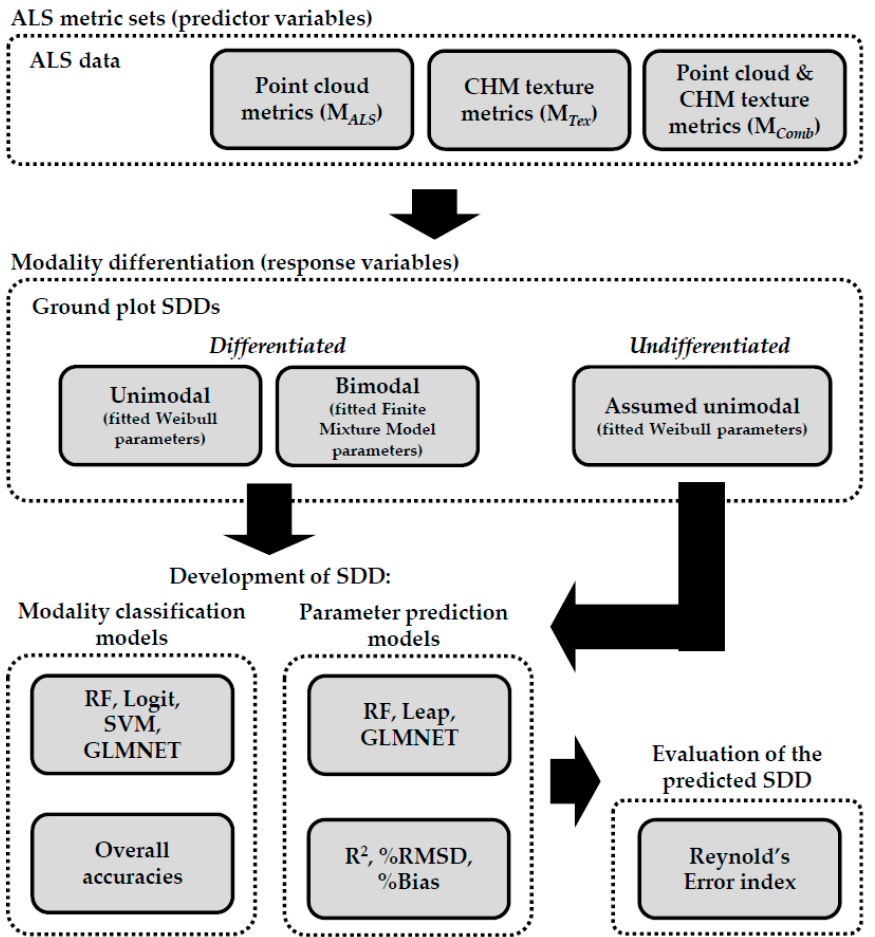
Figure 3. Overview of the methodological approach for assessing the contribution of CHM texture metrics and modality differentiation in predicting stem diameter distribution (SDD) parameters. CHM = Canopy Height Model; RF = Random Forest; Logit = generalized linear model with stepwise feature selection; SVM = Support Vector Machine; GLMNET = Generalized linear model through penalized maximum likelihood; Leap = Best subset regression with branch-and-bound algorithm; R 2 = Coefficient of determination; %RMSD = relative root-mean-squared deviation expressed as a percentage of the mean; %Bias = relative Bias expressed as a percentage of the mean.